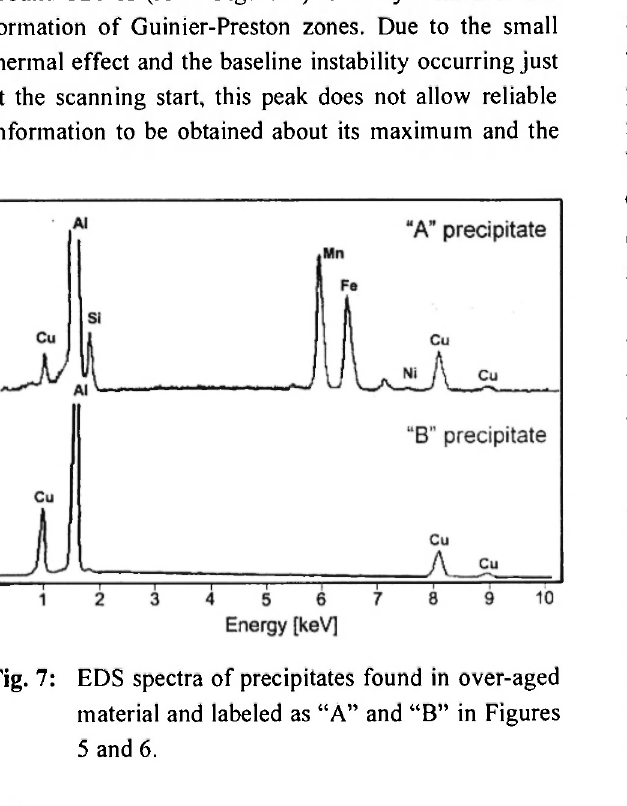
the two precipitates are reported in Fig.7.